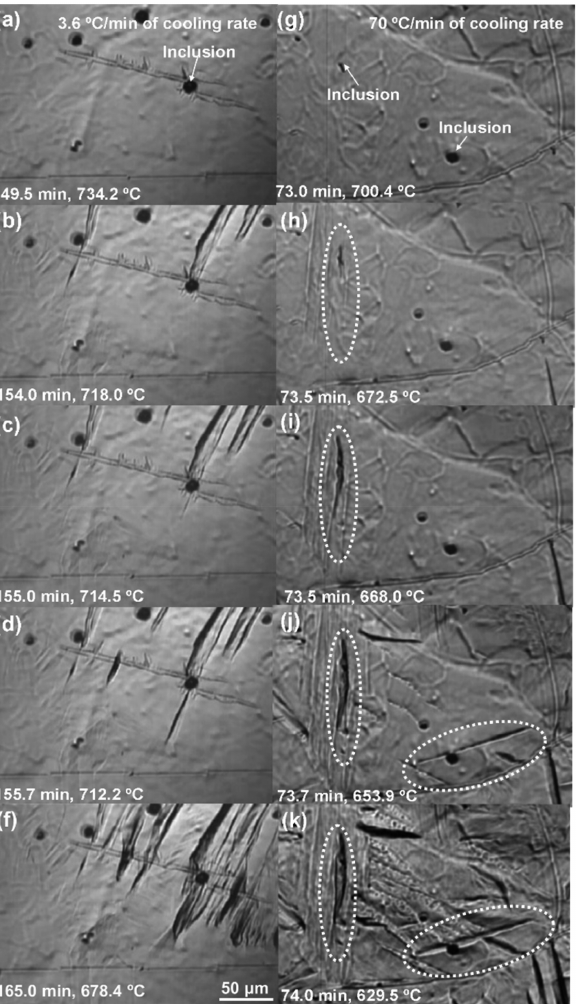
Figure 16: Typical CLSM images for IGF formation in steel with Ti 2 O 3 addition, held at 1400°C/min. (a) to (f) cooling rate of 3.6°C/min, and (g) to (k) cooling rate of 70°C/min from 950 to 400°C [11].